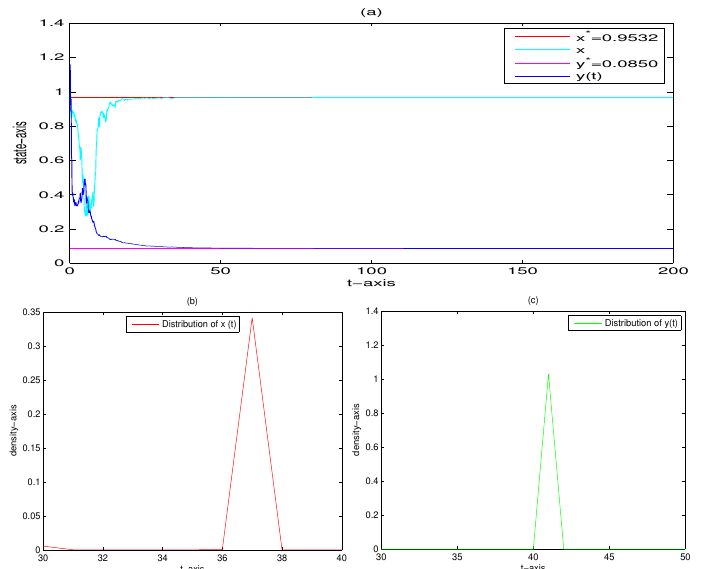
Figure 5. The stationary distribution of (4) with σ 1 = σ 2 = 1: ( a ) time-series curves of x ( t ) and y ( t ) ; ( b ) density distribution of x ( t ) ; and ( c ) density distribution of y ( t ) .